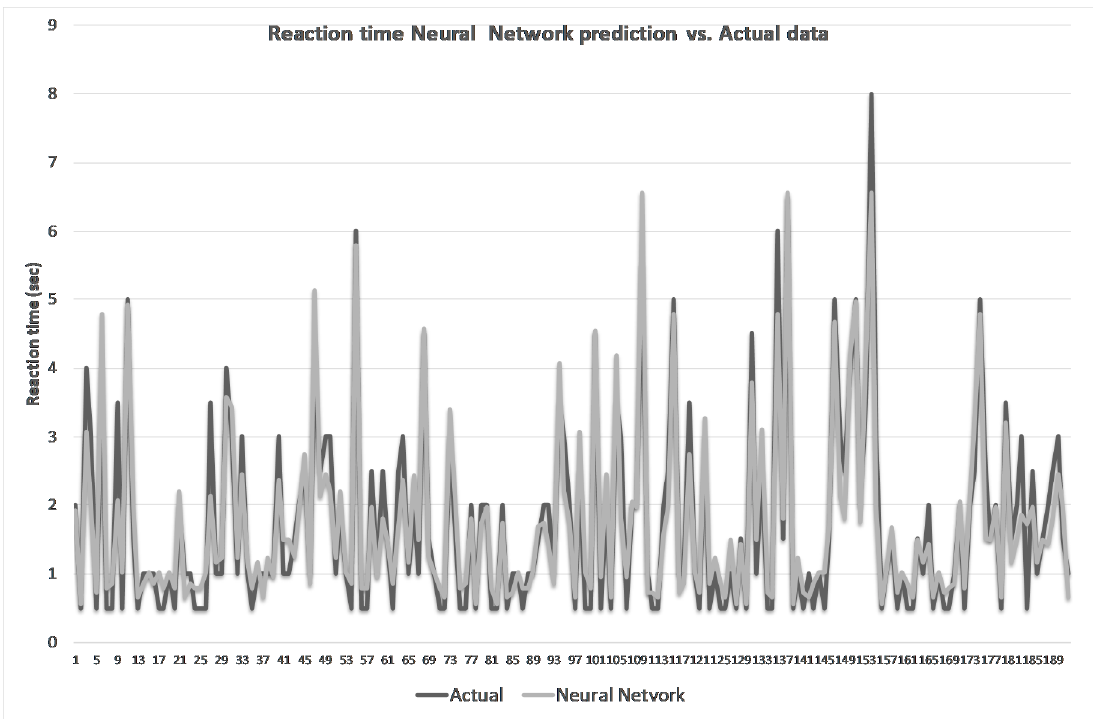
Figure 4. Comparison of modeled and measured children’s reaction times.